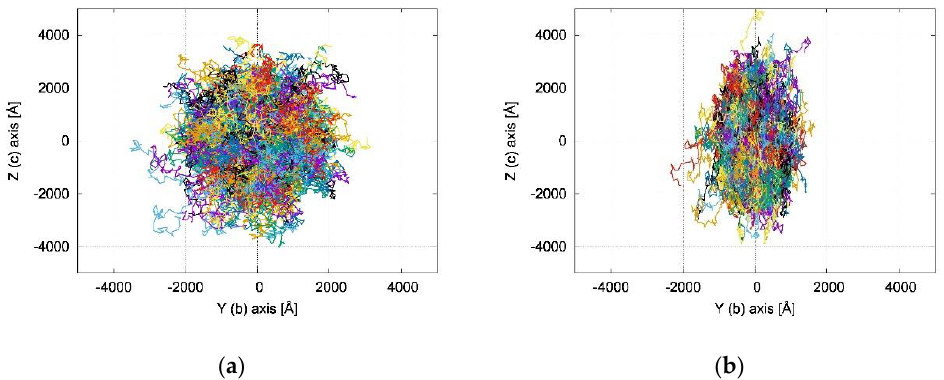
Figure 5. Plot of KMC trajectories (each trajectory with a different color) in the Y( ≡ b ), Z( ≈ c ) plane, showing the 2D character of the charge transport and a different degree of anisotropy for ( a ) N-NDTI ANTI-1 and ( b ) N-NDTI ANTI-2 .